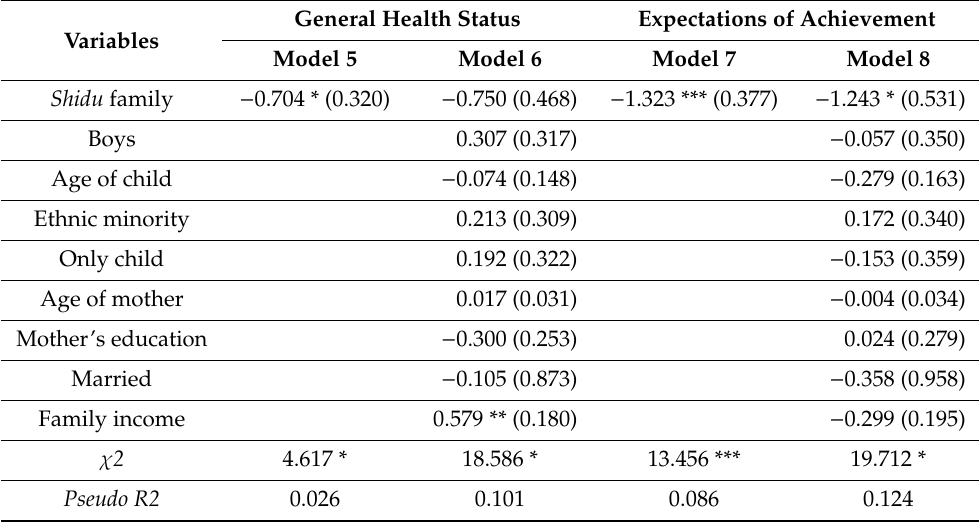
Table 4. Unadjusted and adjusted ordinal logistic regression analyses for mothers’ general health status and expectations of achievement for their children ( n =